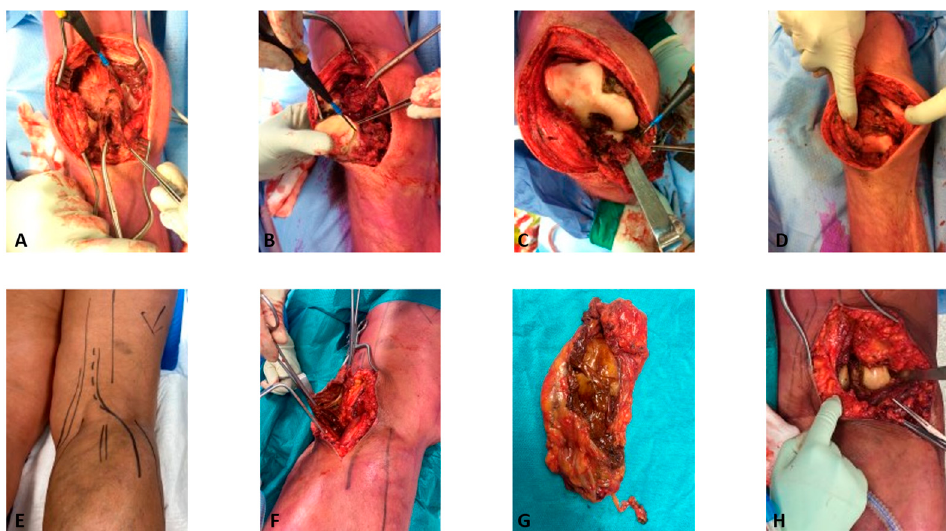
Figure 1. Two-sided synovectomy of the knee. An anterior synovectomy for D-TGCT about the